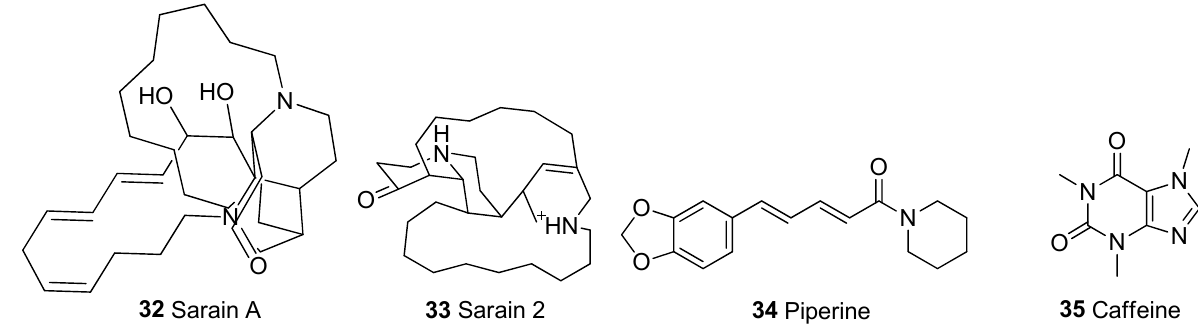
Figure 5. Chemical structures of alkaloids.